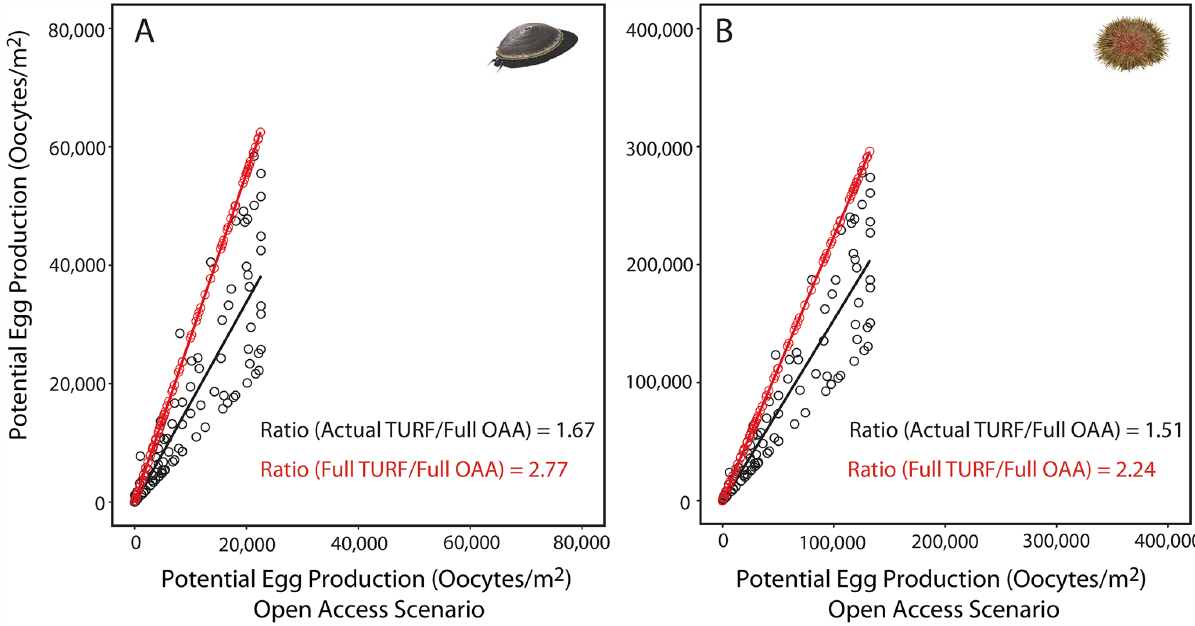
Fig 4. Influence of fishing on potential egg production. Comparisonof potentialegg production between the open access areas (OAAs) scenarioagainst(a) current scenario (existingTerritorialUse Rights for Fisheries, TURFs; black line and symbols) and (b) full protection (all TURFs; red line and symbols) for (A) Fissurellalatimarginata and (B) Loxechinus albus . The numbers in the lower right corner in each plot show the ratio in potentialegg productionfrom the two scenarios.